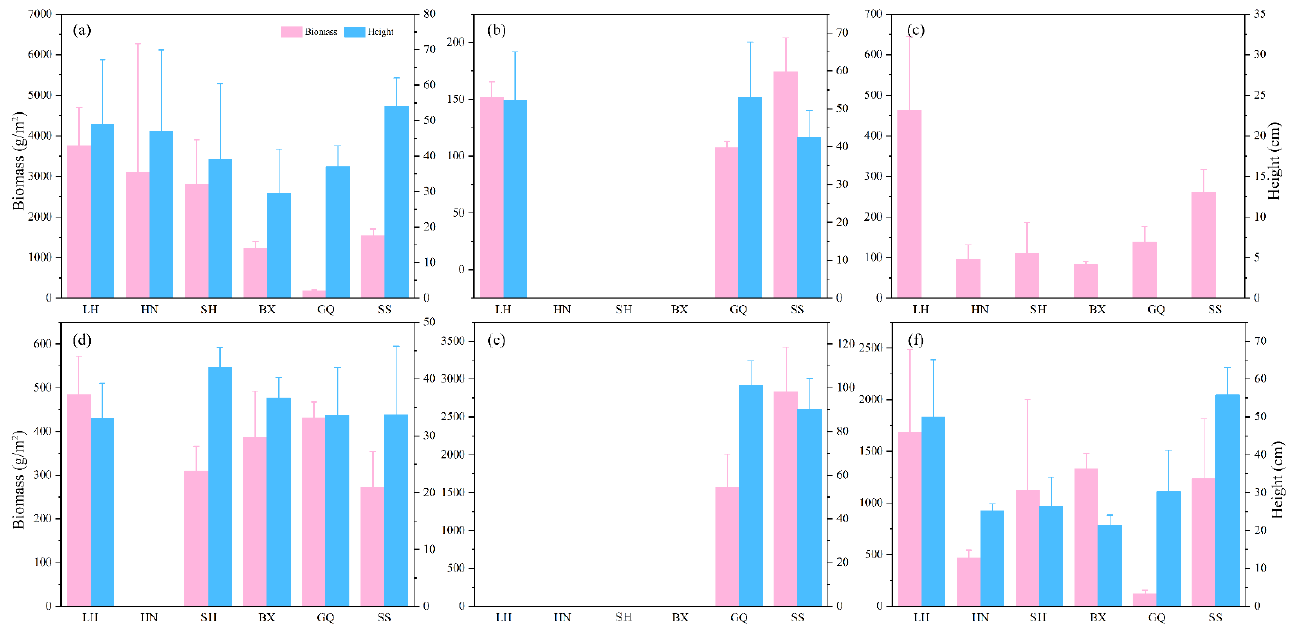
Figure 6. Height and biomass of seaweed species in the Ma ’ an Archipelago. ( a ) Sargassum thunbergii , ( b ) Undaria pinnatifida , ( c ) Ulva pertusa , ( d ) Sargassum vachellianum , ( e ) Sargassum horneri , and ( f ) Sar- gassum fusiforme . Abbreviations: LH (Lvhua), HN (Huaniao), SH (Sanheng), BX (Bixia), GQ (Gouqi), and SS (Shengshan). Ulva pertusa was membranous and its height was not counted.